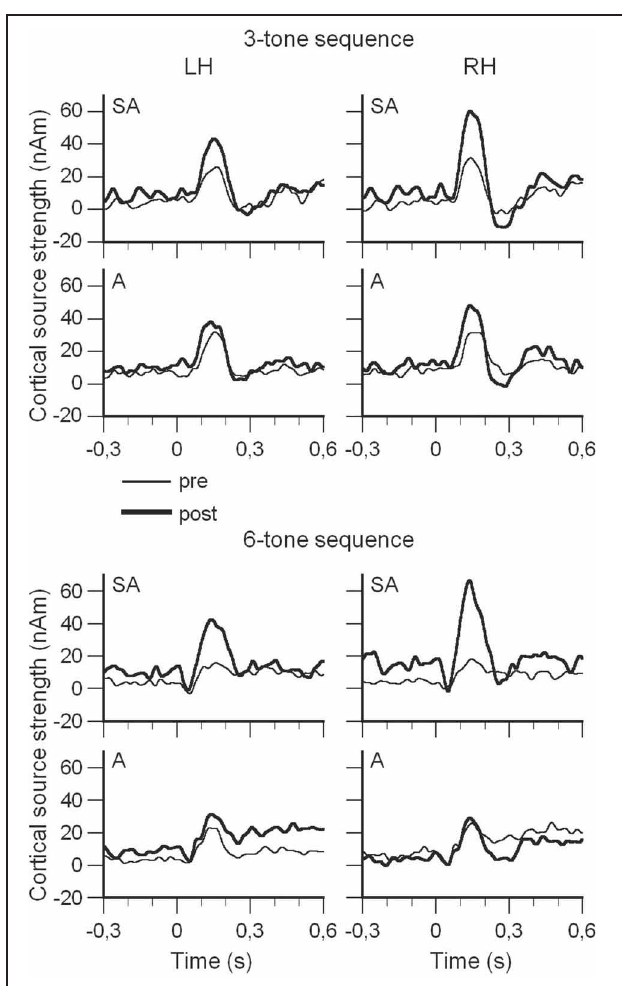
FIGURE 3 | ( Modified from Lappe et al., 2008 ) Group averages of the source waveforms which were obtained after performing source space projection before and after training for both groups (SA = Sensorimotor-Auditory ; A = Auditory ), stimulus conditions, and hemispheres. Data for the three-tone sequences are shown in the top four panels and data for the six-tone sequences in the bottom four panels. Within each set of four panels, SA group data are shown in the top row, and A group data are shown in the bottom row. Data from the left hemisphere (LH) are presented on the left and those of the right hemisphere (RH) on the right. Thin lines indicate pre-training (pre) data and thick lines post-training (post)